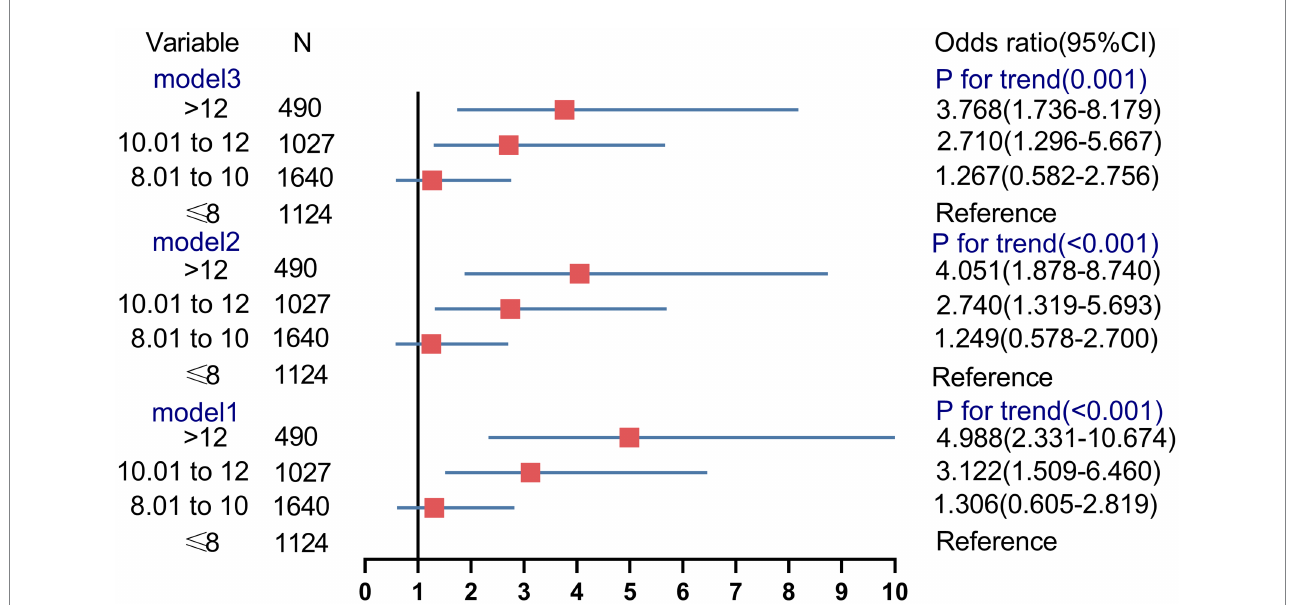
FIGURE 6 Association between the different groups of white blood cell count and risk of noninvasive prenatal screening